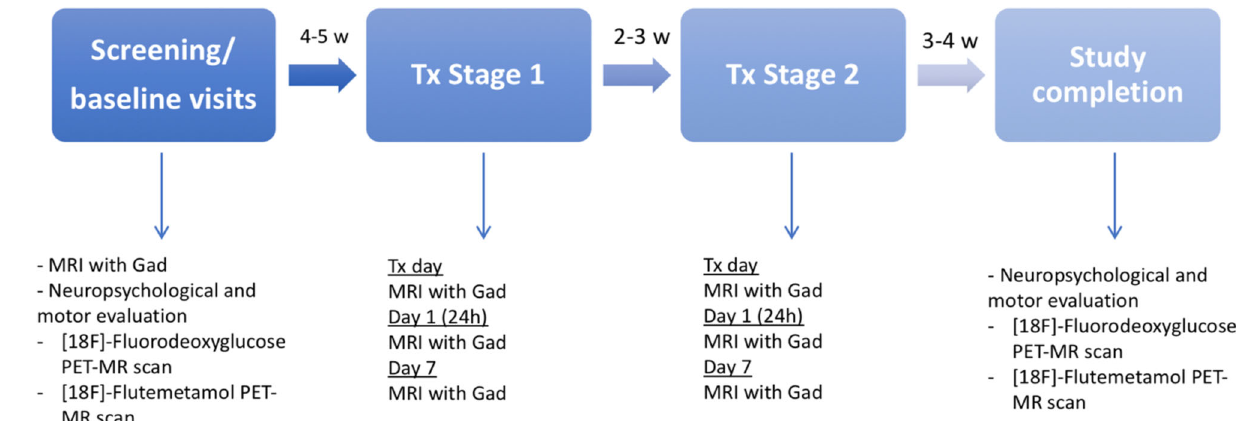
Fig. 4 Chronogram of the study investigations and procedures. Tx treatment, Gad gadolinium, MRI magnetic resonance imaging, PET positron emission tomography, w